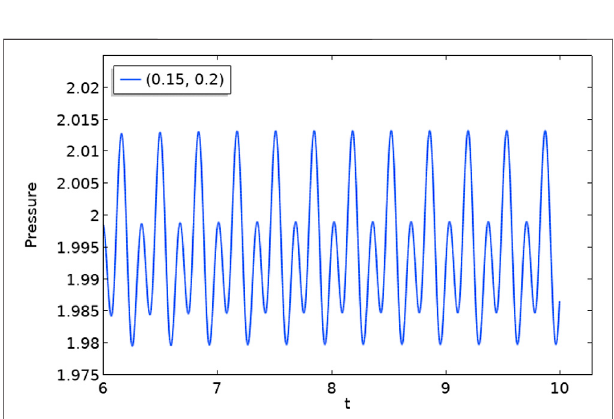
FIGURE 8 | Line graph of the pressure pro fi le for the Newtonian case ( n (cid:2) 1 ) .